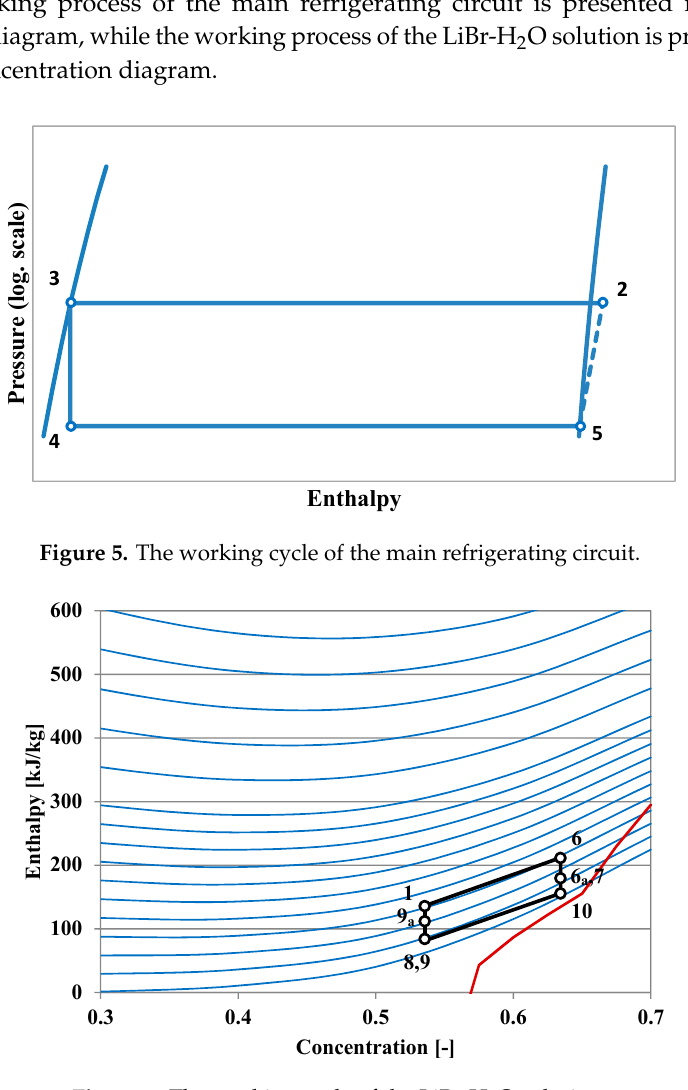
Figure 6. The working cycle of the LiBr-H 2 O solution.